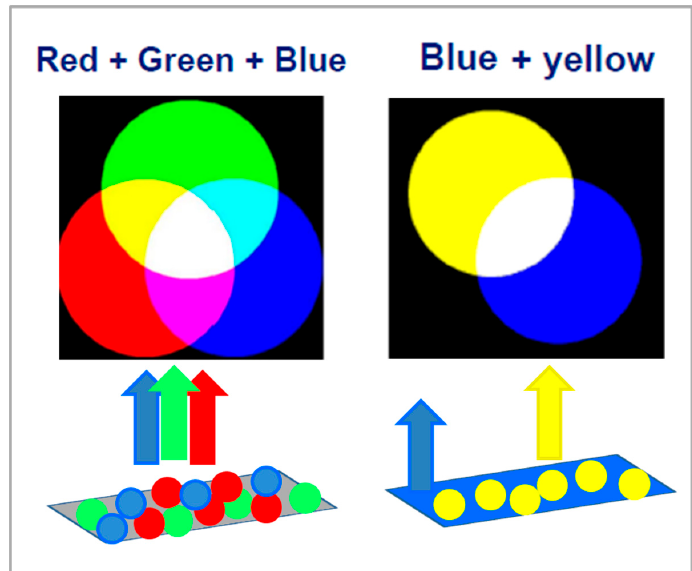
Figure 6. Most common principles used in white light emitting LEDs: (left panel) a (near-)ultraviolet (UV) emitting LED combined with RGB emitting phosphors and (right panel) a blue-emitting LED irradiating a yellow phosphor.